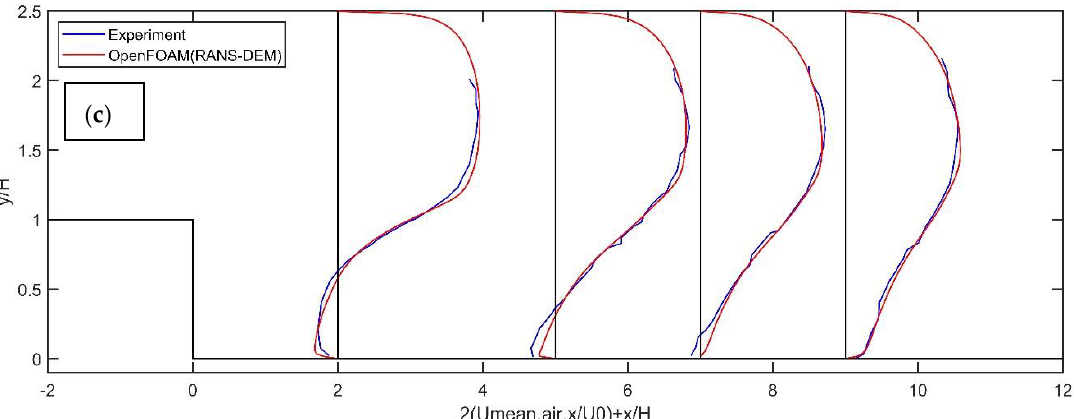
Figure 9. Comparisons of experimental and OpenFOAM simulated streamwise air mean velocity profiles at the measurement locations for two-way coupling and 10% mass loading of copper particles under RANS-DEM framework. ( a ) Particle injection velocity as (10.5, 0, 0) m/s, ( b ) particle injection velocity same as that of the fluid velocity profile at the inlet, ( c ) particle injection velocity as (0, 0, 0) m/s.